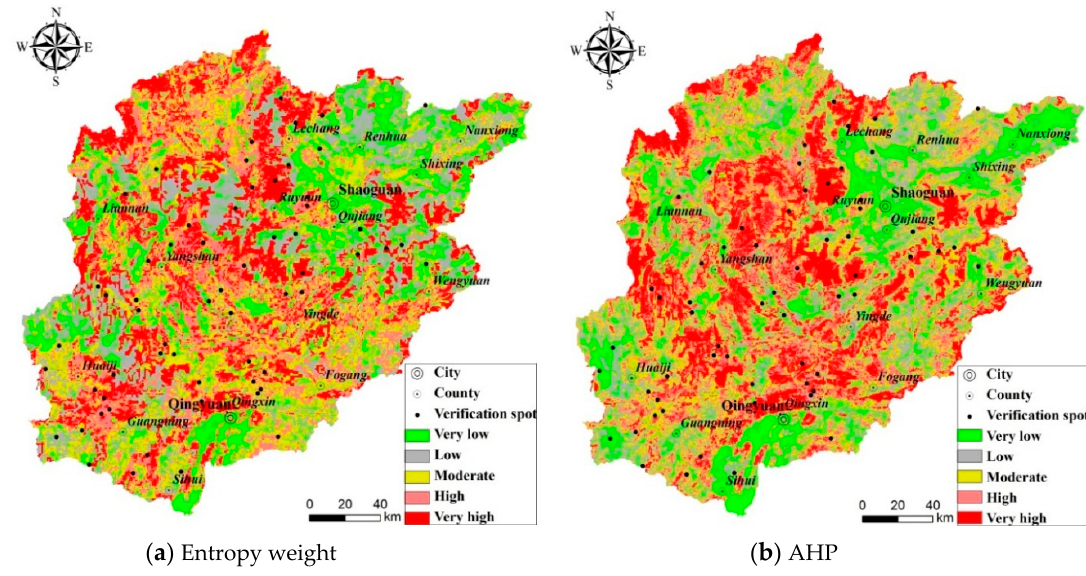
Figure 8. Landslide susceptibility maps based on entropy weight and weight determined by AHP.